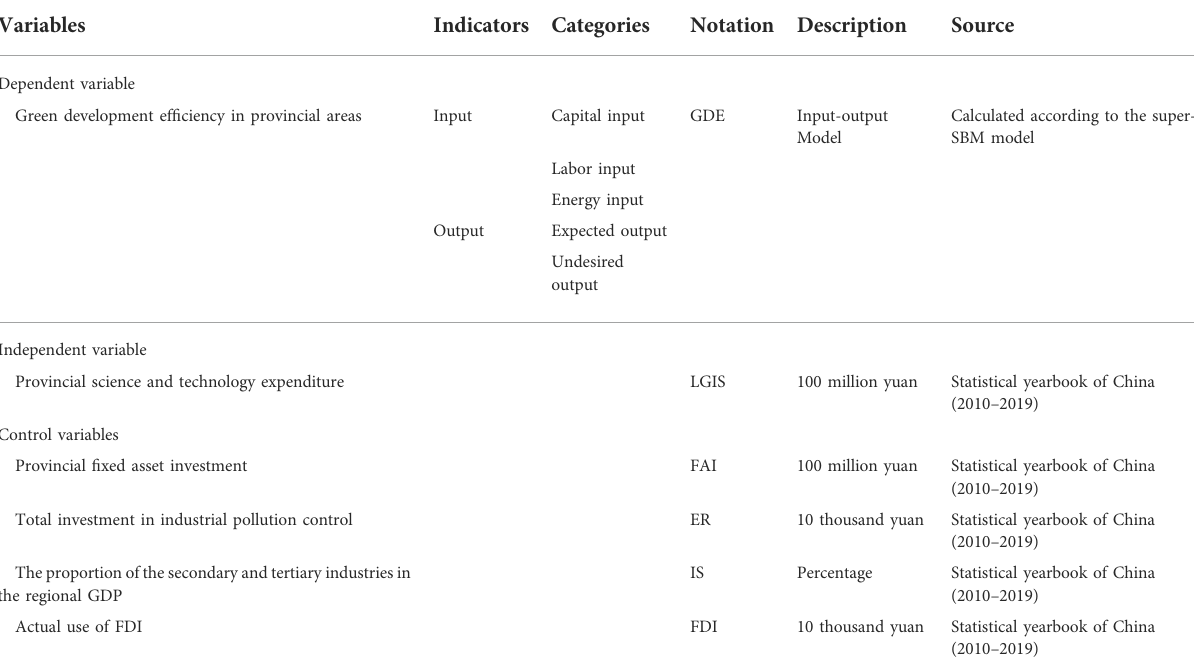
TABLE 2 Data description, including notation and